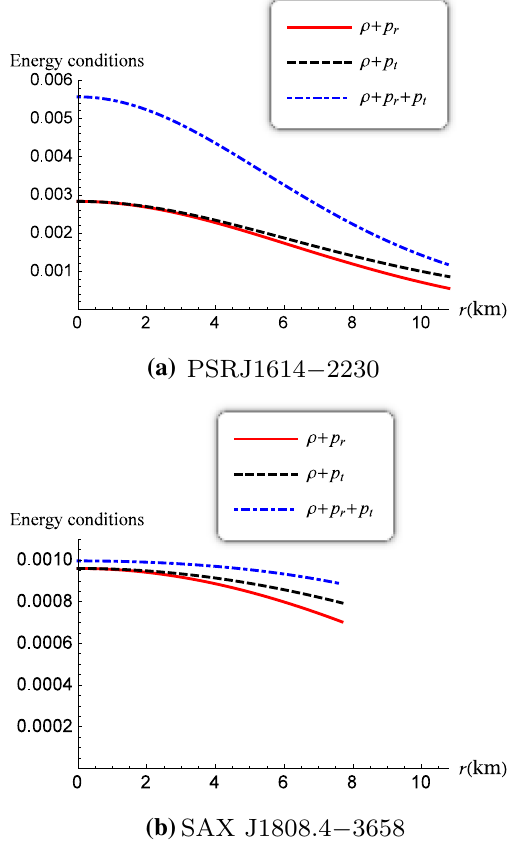
Fig. 6 Variation of energy conditions verses the radius